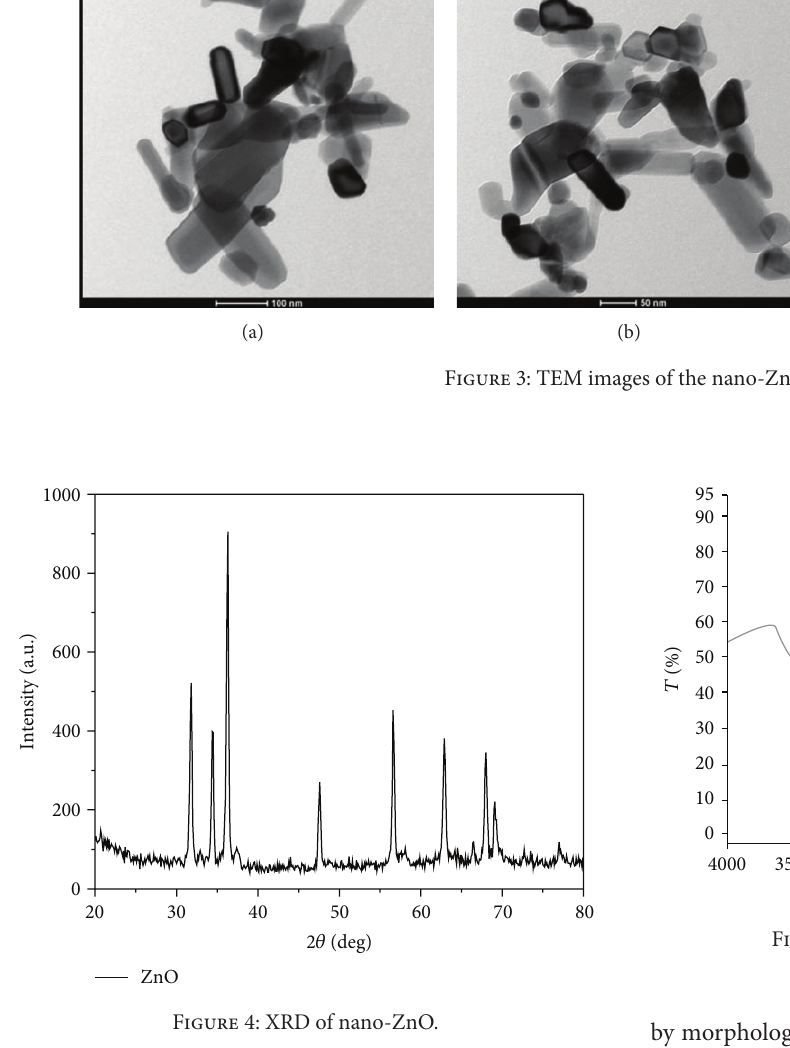
by morphology and the particle size. Figure 5 illustrates the FTIR spectrum of the ZnO